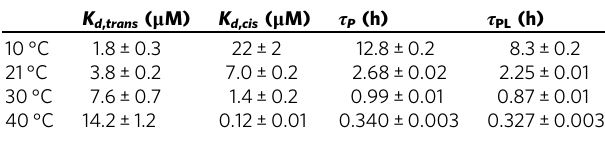
Table 1 Binding af fi nities and cis -to- trans isomerisation time-constants as a function of